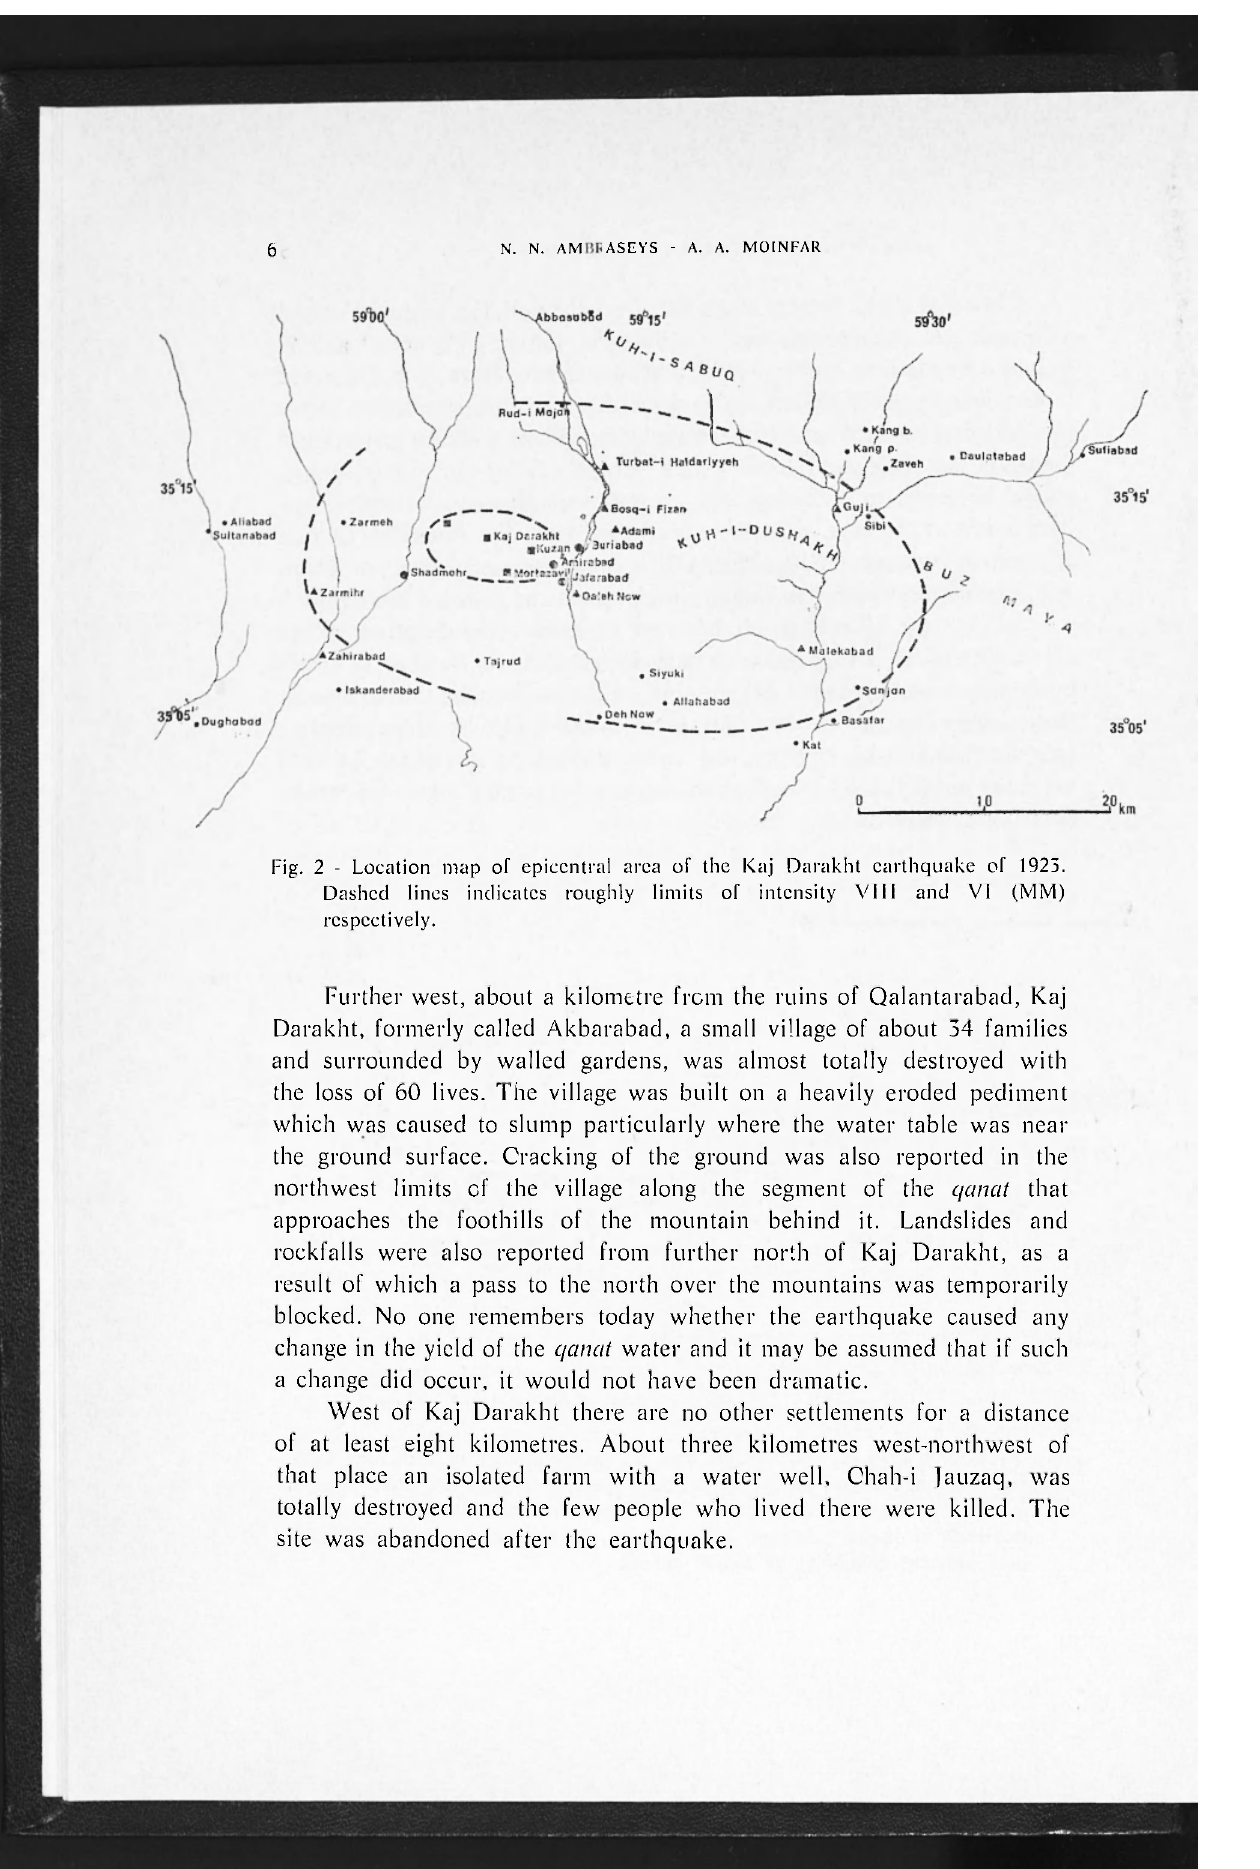
Fig. 2 - Location map of epicentral area of the Kaj Darakht earthquake of 1923. Dashed lines indicates roughly limits of intensity VIII and VI (MM)